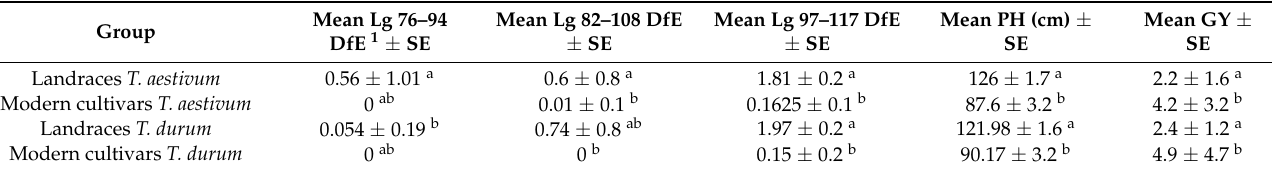
Table 2. Mean lodging (Lg) score of three independent assessments during the vegetative and reproductive stage, plant height (PH), and grain yield (GY).